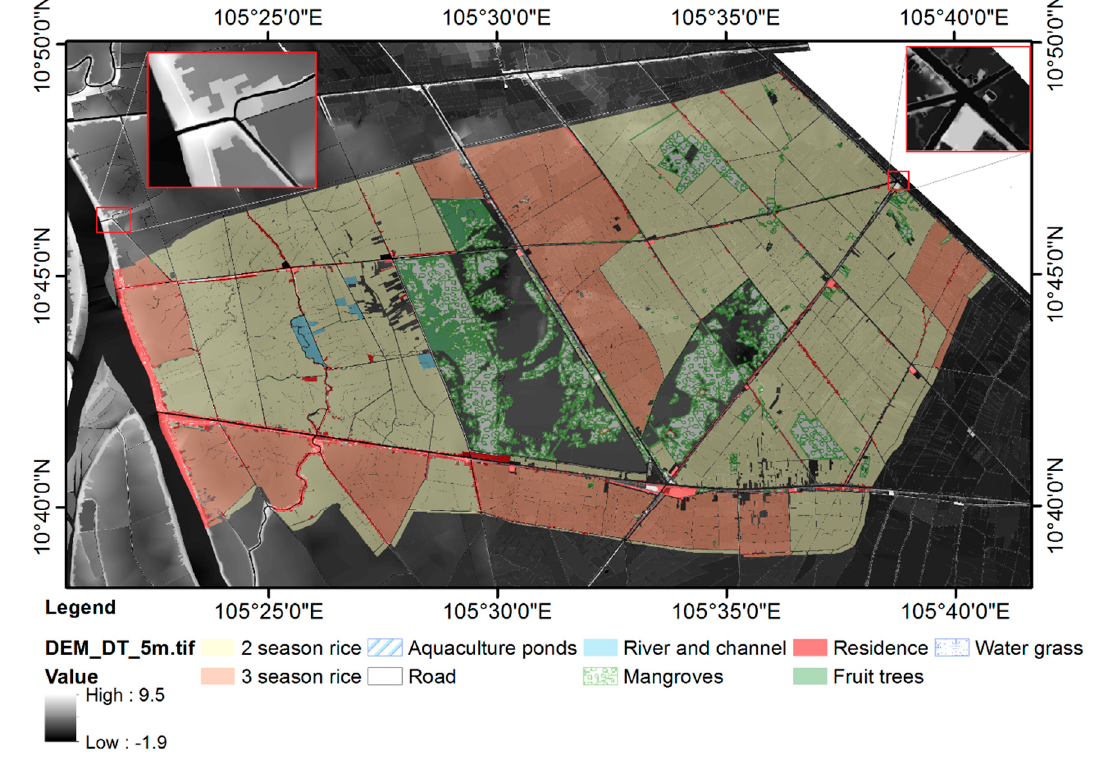
Figure 6. Land use / land cover (LULC) map of Tam Nong district, which was updated in October 2018 Figure 6. Land use/land cover (LULC) map of Tam Nong district, which was updated in October 2018 and overlaid with the 5 m digital elevation model and overlaid with the 5 m digital elevation model (DEM).